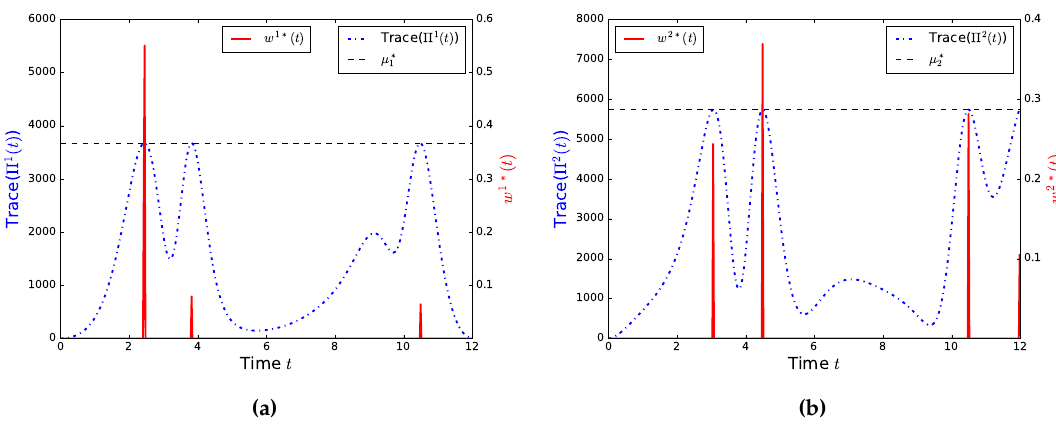
Figure 3. Visual relation between the trace of the information gain matrices Π 1 ( t ) , Π 2 ( t ) , the Lagrange multipliers µ ∗ , µ ∗ and the optimized sampling decisions w 1 2 1